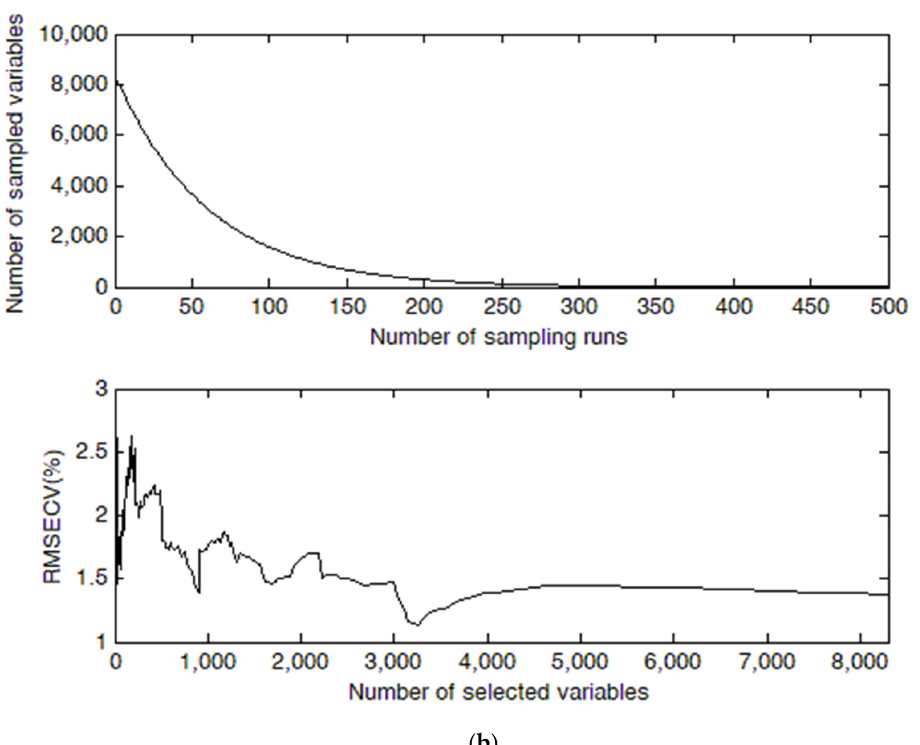
Figure 3. Plots of characteristic variable selection based on CARS for cellulose in Sargassum horneri . Plot ( a ), (( b ) upper), and (( b ) lower) show the regression coefficient, number of sampled variables, and RMSECV value,